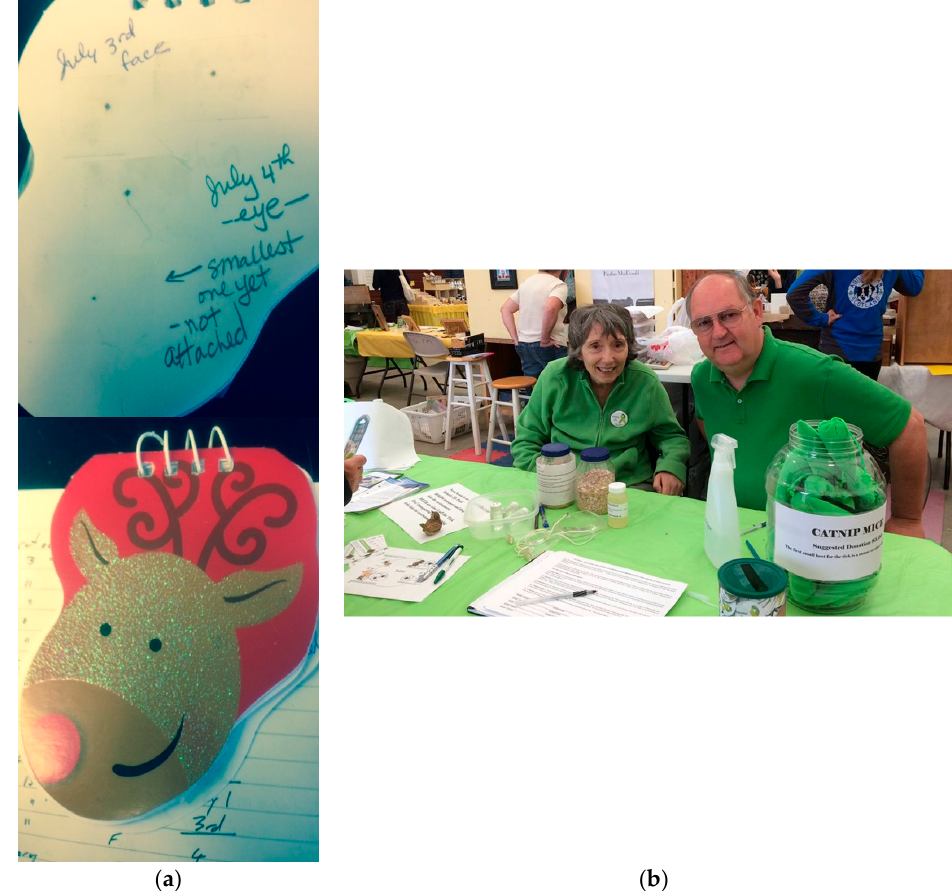
Figure 2. Community-initiated tick bite prevention education. ( a ) Ticks collected by a community member, taped to a notebook for display in schools (St. John collection); ( b ) Community members Brenda Sterling-Goodwin and Steve Goodwin at a Lyme awareness–tick education table at the New Glasgow, Nova Scotia, farmer’s market in 2015. The containers in the center of the table contain ticks of different species and life stages obtained from two of the community-initiated tick surveillance collections described here (Nova Scotia and Hampton collections).